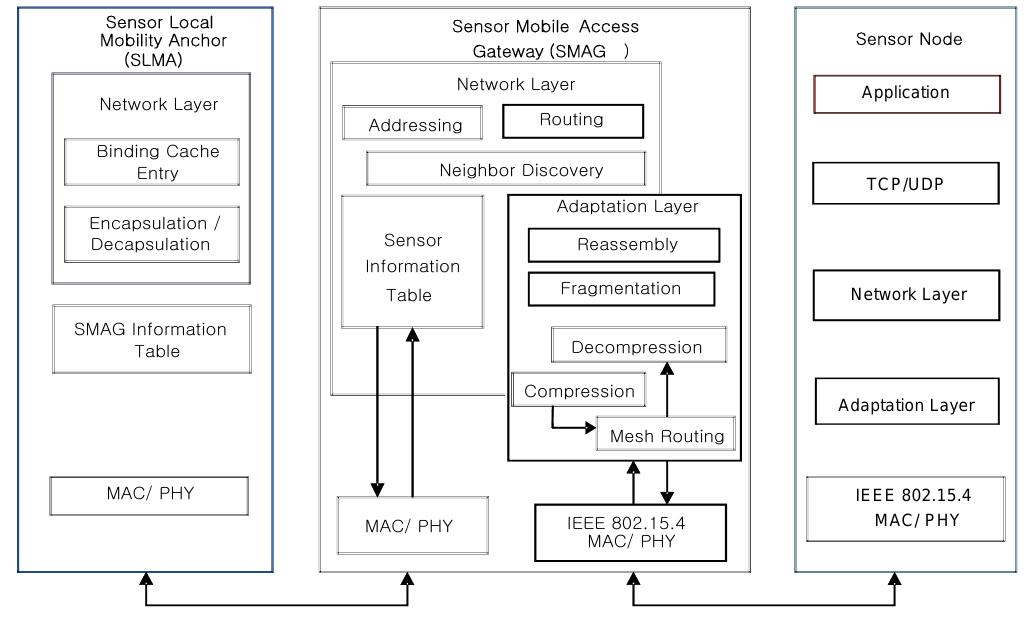
Figure 2. Operational Architecture of